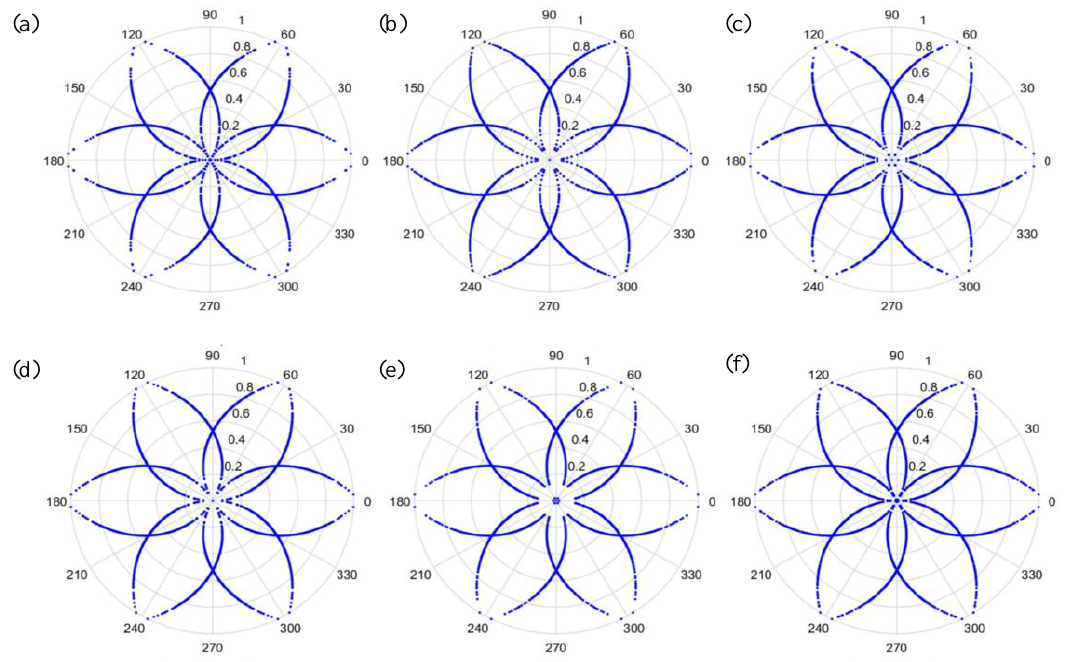
Figure 6. Results when t = 0 and sampling is at 1000 Hz / 1000 rpm. ( a ) Normal, ( b ) motor platform with one eccentric screw, ( c ) motor platform with two eccentric screws, ( d ) sanded ball bearings, ( e ) insufficient lubrication, and ( f ) worn ball bearings.